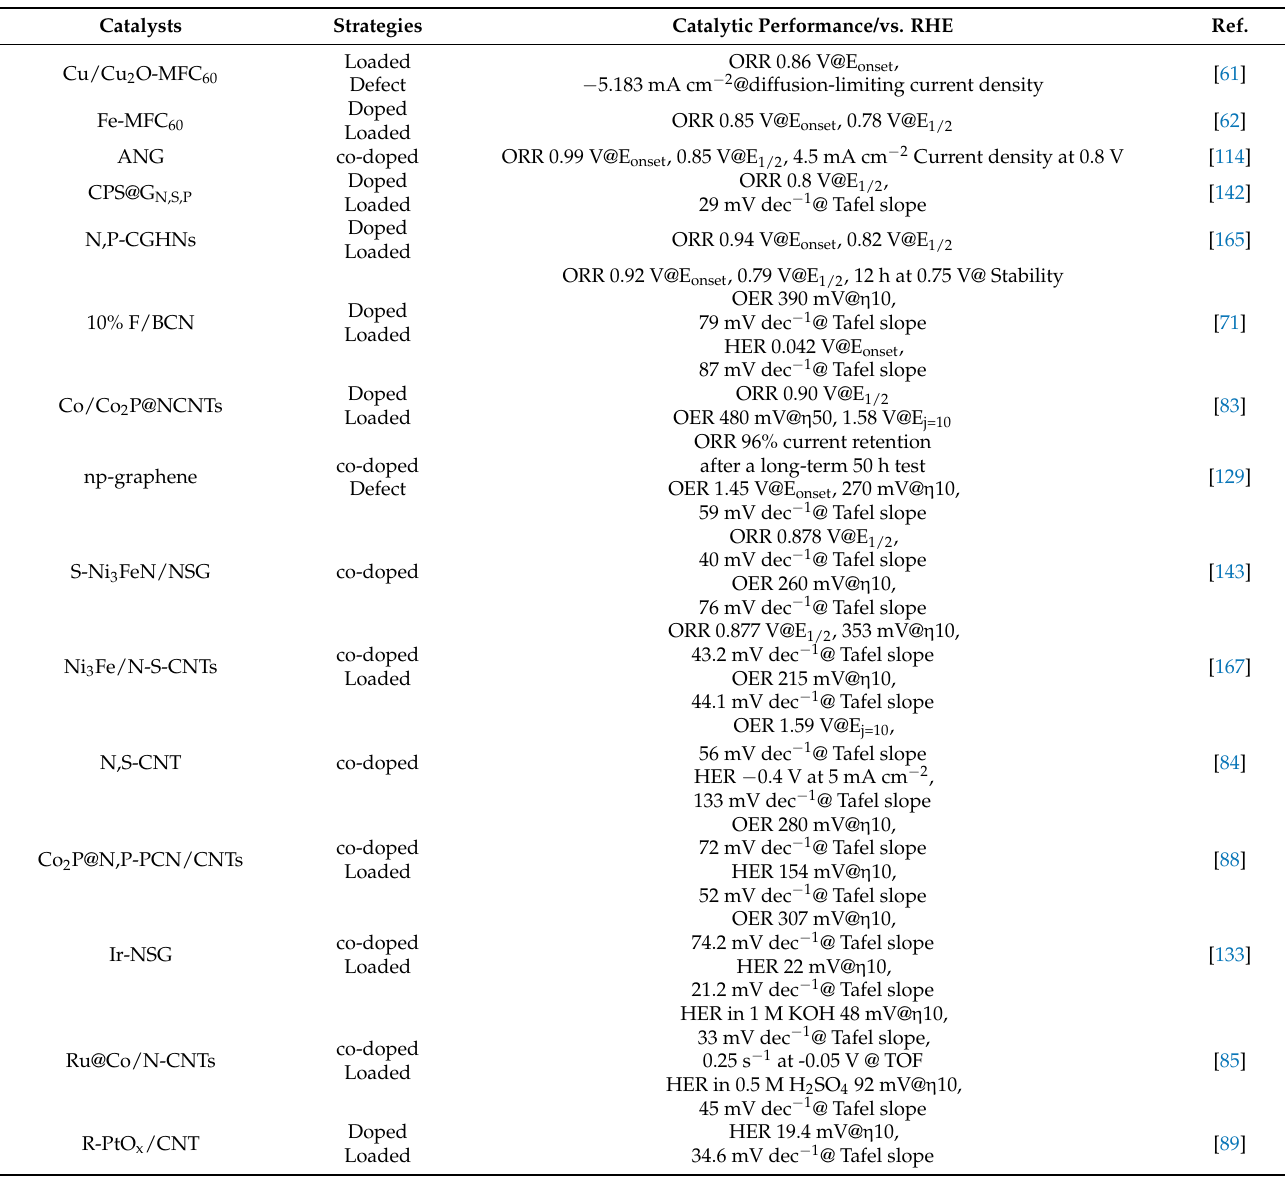
Table 1. Summary of Catalytic performance of discussed catalysts in the main